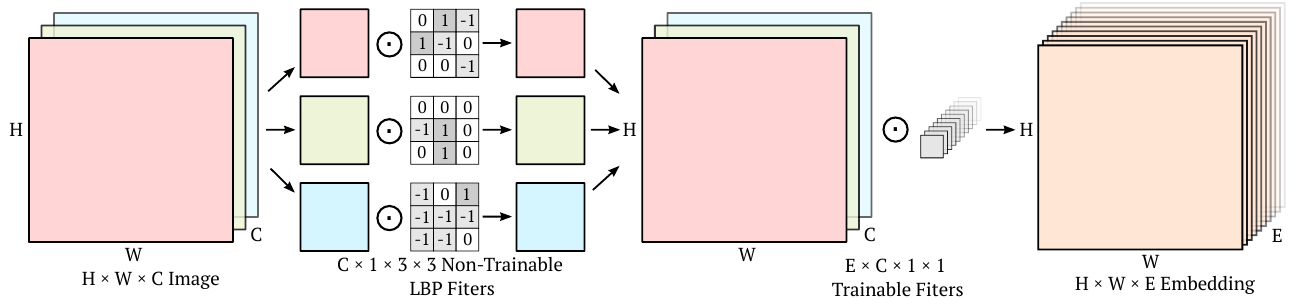
Figure 1. DSC LBC convolution block used to replace a standard convolution. A given convolution operation can be considered to have X filters of size K × K × Y where X is the number of output channels, Y is the number of input channels divided by the number of convolution groups, and K is the width and the height the kernel. A DSC LBC convolution replaces the trainable depthwise filters of a depthwise separable convolution [24] with sparse, non-trainable filters inspired by local binary patterns [28]. Note that there is only one distinct non-trainable binary filter convolved with each input channel in the first stage of the DSC LBC convolution block.